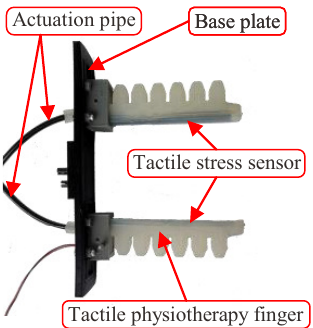
Figure 1. Finished product of the